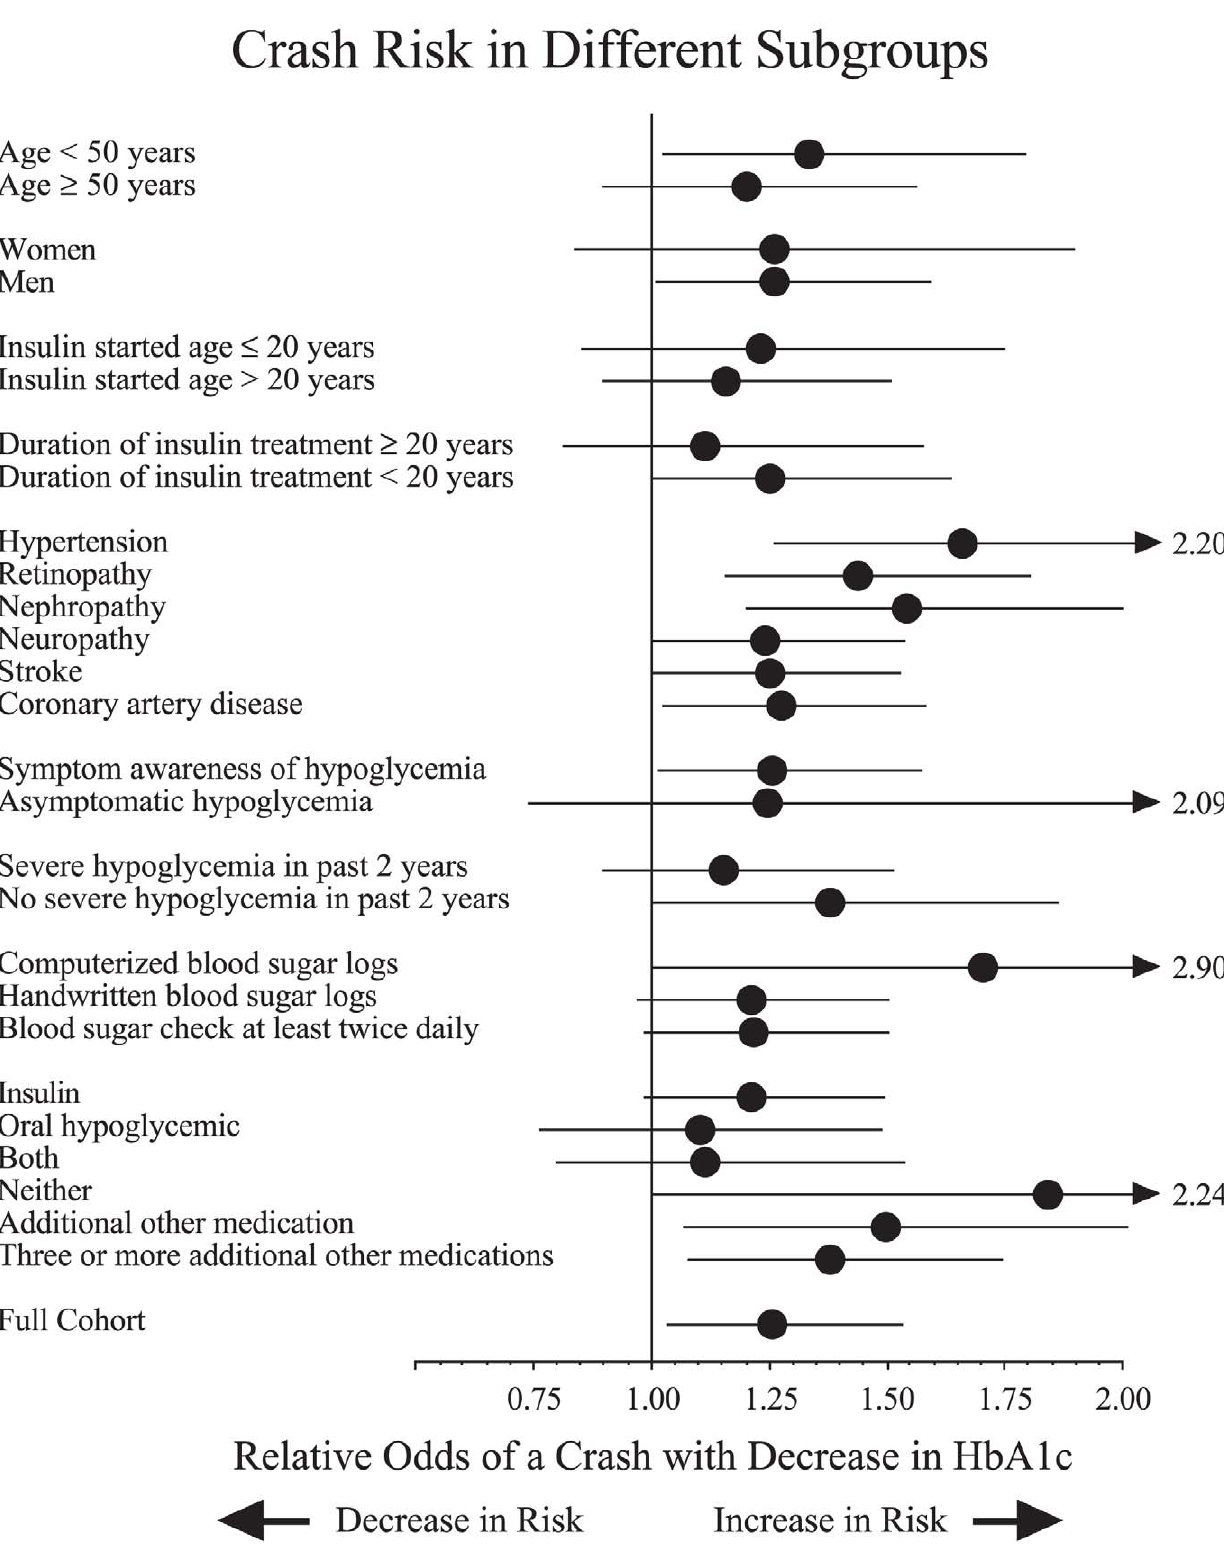
Figure 2. Crash risk in different subgroups. Each analysis examines correlation of lower HbA1c levels with higher risk of a crash. Results expressed as odds ratio (solid circle) and 95% confidence interval (horizontal line) per 1% point decrease in HbA1c. Analyses of chronic complication subgroups exclude patients reporting corresponding symptom. Results for full cohort appear at bottom and show an odds ratio of 1.26 with 95% confidence interval 1.03–1.54.